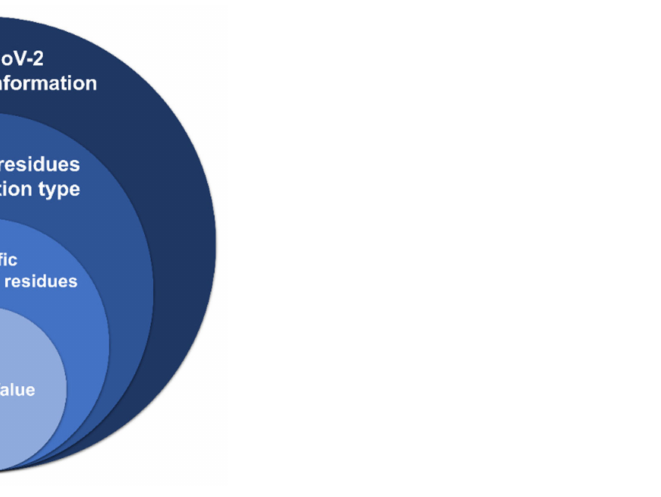
Figure 2. The selection criteria for the most accurately resembling docked protein cluster generated by the High Ambiguity Driven DOCKing (HADDOCK)